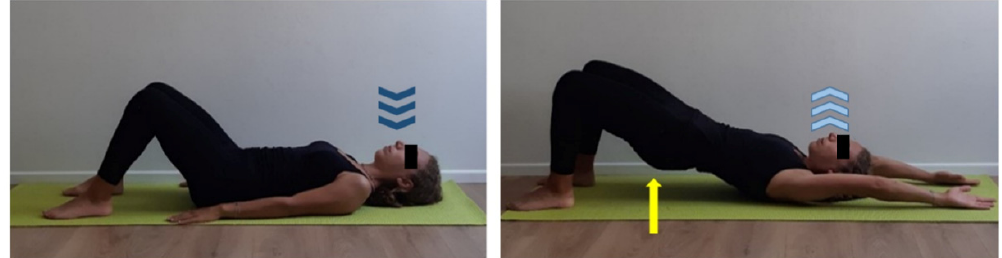
Figure 8. Glutes strengthening exercise paired to shoulders mobilization. Supine position, flex both legs, set feet hip-width apart close to glutes, rest straight arms by body sides and hand palms on the floor. Inhale (dark blue arrows), exhale (light blue arrows), lift glutes (yellow arrow) performing a bridge and simultaneously flex straight arms upward until reaching the floor with the back of both hands. Inhale and get back to start position activating abdominal muscles contraction. Two sets of 10 repetitions, 1 min recovery.